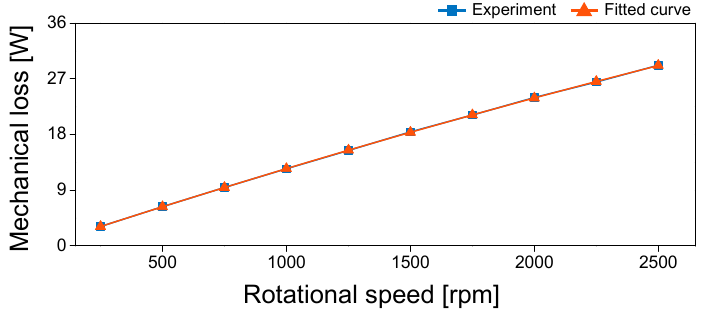
Figure 10. Experiment results for mechanical loss measurement.